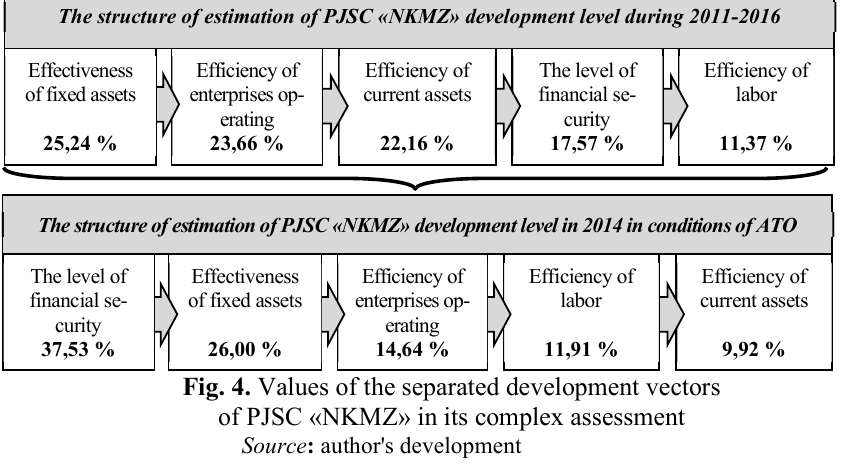
Fig. 4. Values of the separated development vectors of PJSC «NKMZ» in its complex assessment Source : author's